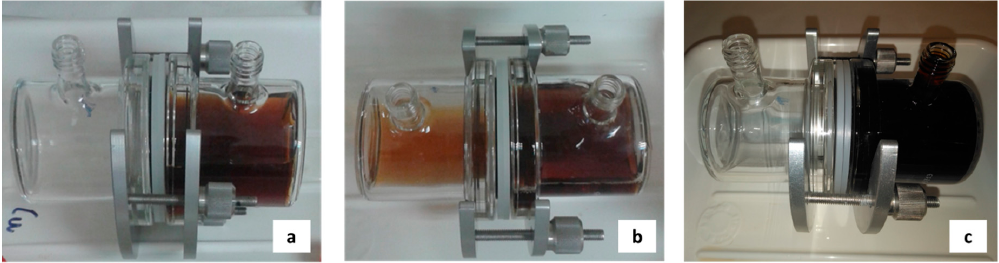
Figure 12. Images of the permeability tests of virgin PVDF membrane ( a ), SILM with CYPHOS 108 in PVDF ( b ), and SILM with [BMIM][DBP] in PTFE ( c ).